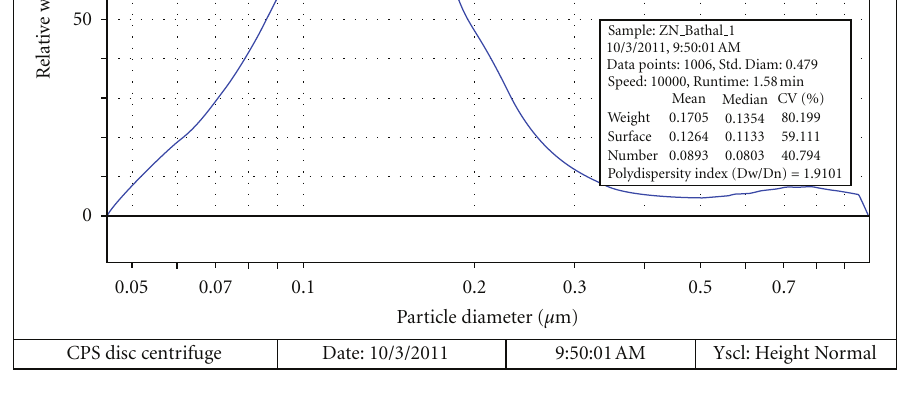
Figure 3: Particle size analyzer.